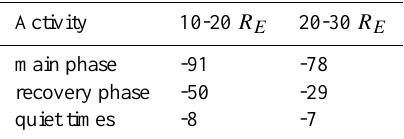
Table 2. Average D st values for the data in each distance bin